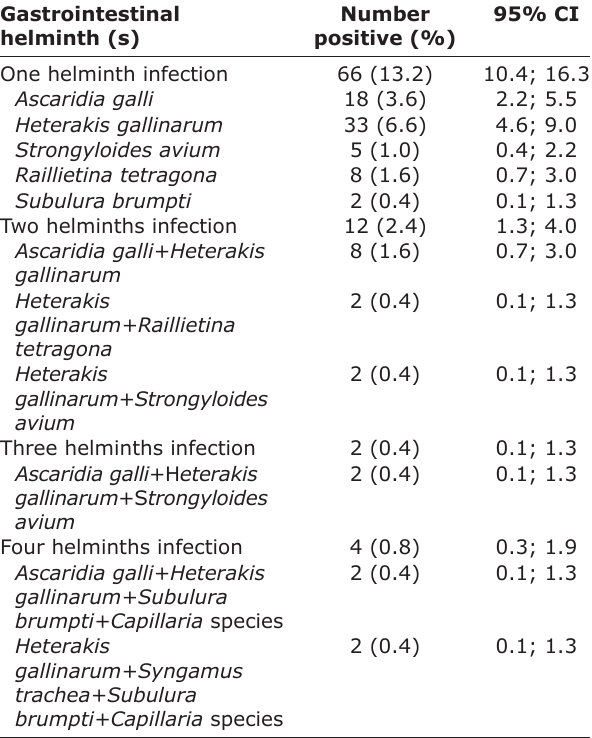
Mean intensity of infections (EPG of feces) of hel- minth parasites in the different poultry farms